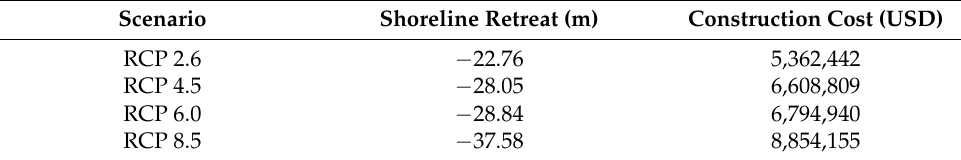
Table 7. Beach nourishment construction cost of Chalatat beach.